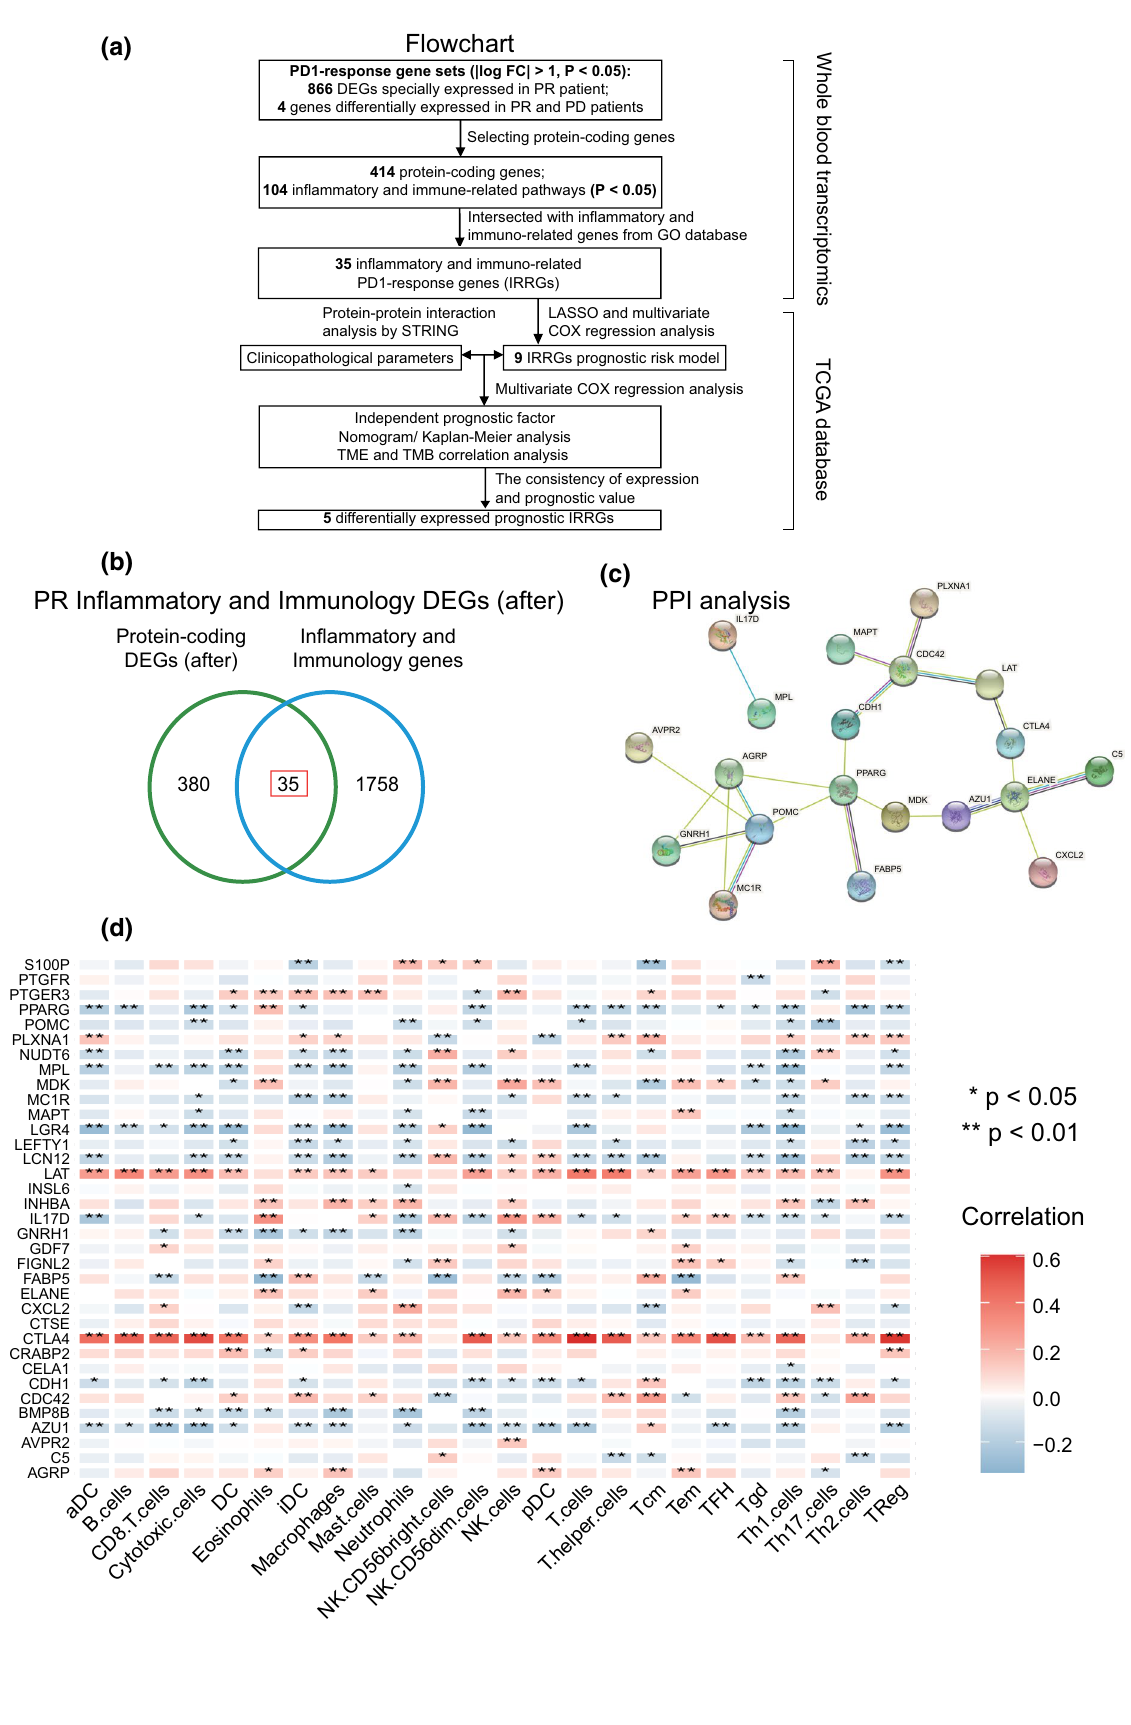
4 genes differentially expressed in PR and PD patients Selecting protein-coding genes 414 protein-coding genes; 104 inflammatory and immune-related pathways (P < 0.05) Intersected with inflammatory and immuno-related genes from GO database 35 inflammatory and immuno-related PD1-response genes (IRRGs) Protein-protein interaction LASSO and multivariate analysis by STRING COX regression analysis 9 IRRGs prognostic risk model Clinicopathological parameters Multivariate COX regression analysis Independent prognostic factor Nomogram/ Kaplan-Meier analysis TME and TMB correlation analysis The consistency of expression and prognostic value 5 differentially expressed prognostic IRRGs